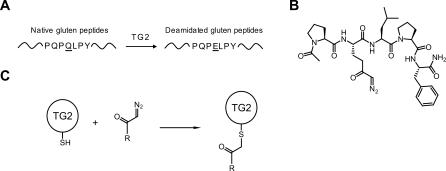
Inactivation of TG2 by a Reactive Gluten Peptide Mimic(A) In the pathogenesis of celiac sprue, TG2 deamidates specific Gln residues in gluten peptides to Glu.(B) The inhibitor Ac-P(DON)LPF-NH2 mimics a gluten peptide sequence that has high affinity for TG2. DON is the electrophilic amino acid 6-diazo-5-oxo norleucine.(C) The active-site Cys residue of TG2 nucleophilically attacks DON, resulting in a stable thioether adduct.